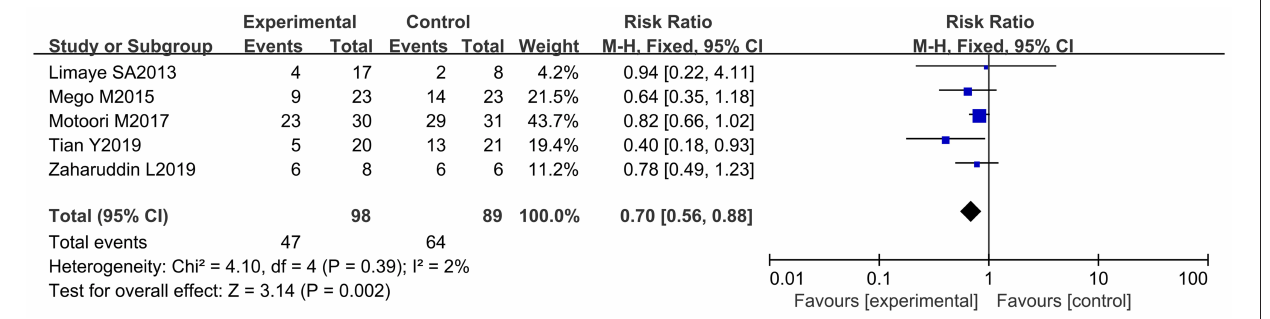
FIGURE 3 | Forest plot of the efficacy of oral probiotic use against diarrhea in cancer patients.